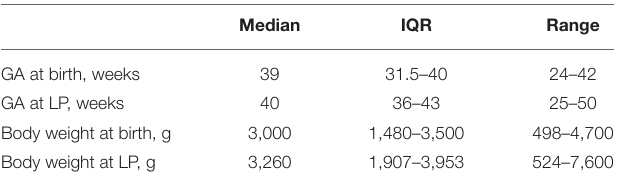
TABLE 1 | Gestational age and body weight at birth and at the time of lumbar puncture.